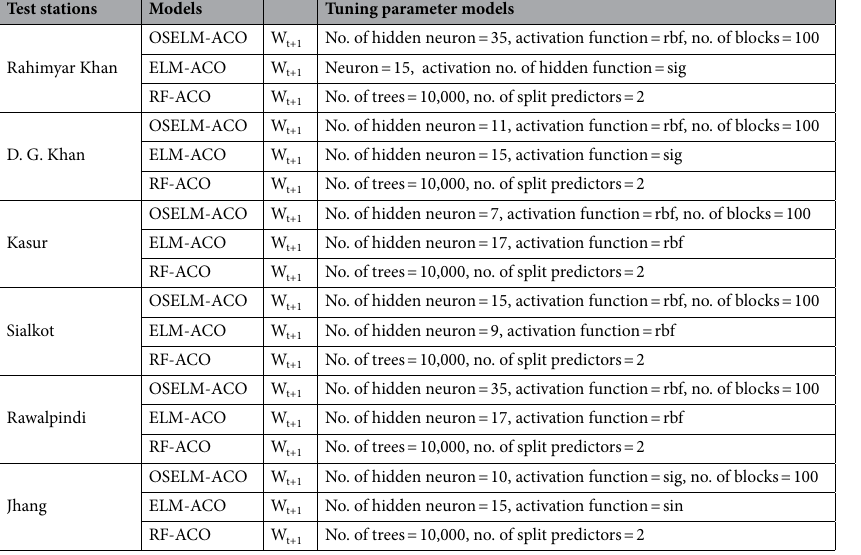
Table 5. Tuning parameters of the ACO-OSELM, ACO-ELM and ACO-RF models to predict wheat yield.